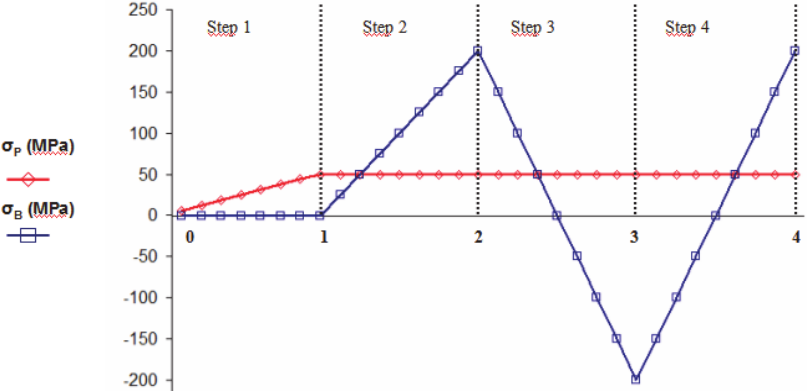
Figure 6: Loads applied to the numerical model for one of the cases studied (case 3). Evolution with